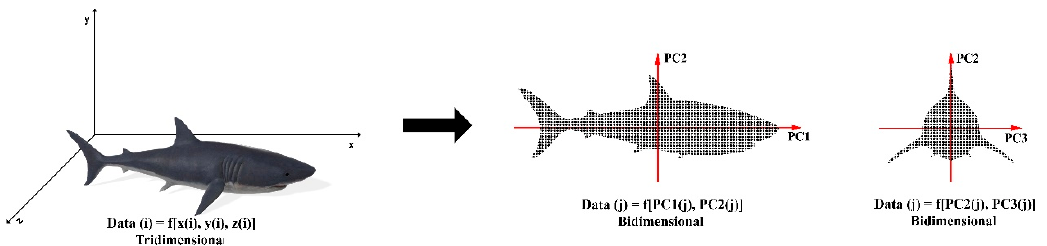
Figure 2. Representation of principal component analysis (PCA). Original data at left side, PC1 × PC2 in the middle and PC2 × PC3 at right side.